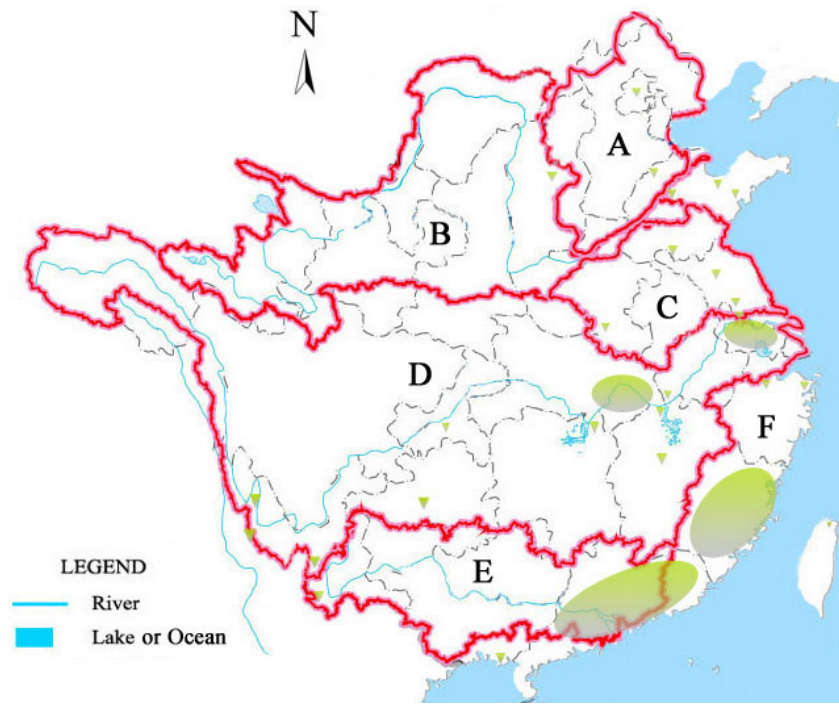
Figure 2. Distribution of R. raciborskii in major river basins of China. A, Haihe River basin; B, Huanghe River basin; C, Huaihe River basin; D, Yangtze River basin; E, Zhujiang River basin; F, basins of southeastern rivers. Blue-green color, areas with presence of R. raciborskii. The wide distribution of R. raciborskii in the same basin (Figure 2) indicated that this species might be dispersed from upstream lakes to downstream lakes through the river (Figure 3). On the other hand, lakes located separately in floodplain could be linked by large floods, creating opportunities for R. raciborskii to invade new environments.